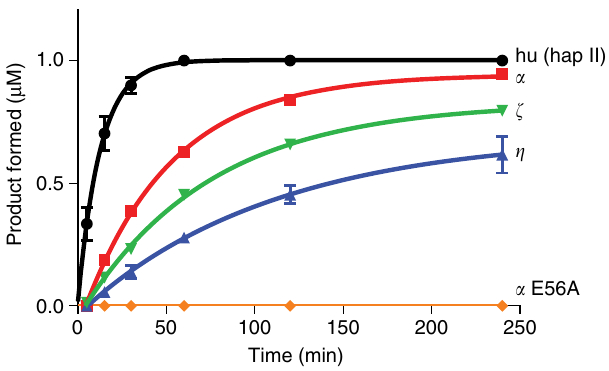
Fig. 2 Cytidine deaminase activity of recombinant A3H variants. Single- stranded DNA (1 μ M) containing a single reactive cytosine base was combined with 100 nM A3H coupled with 40 nM uracil deglycosylase, and products were detected by denaturing gel electrophoresis. The active site mutant pgtA3H α E56A 13 was used as a negative control for A3H deaminase activity; no activity was detected. Mean and standard deviation of n = 3 experiments. Initial rates are reported in Table 1